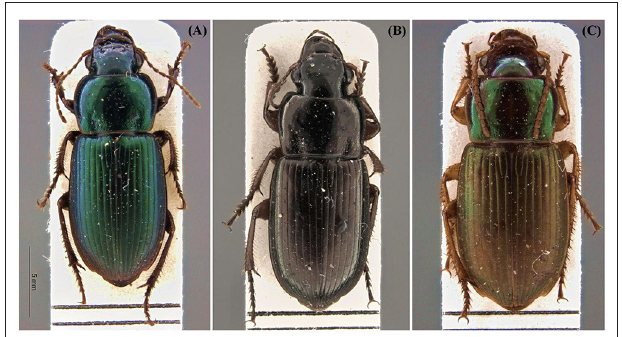
FIGURE 2 | Photographs of the three Harpalus affinis color morphs “green,” “bronze,” and “mixed,” from the collections of the Museum für Naturkunde, Berlin. (A) (green ♀ ): Berlin, Prenzlauer Berg, Oderbruchkippe, 17, June 1972. (B) (bronze ♂ ): Brandenburg, nature reserve Mallnow near Seelow, 24, August 1975. (C) (mixed ♀ ): Berlin, Prenzlauer Berg, Oderbruchberg, 24, August